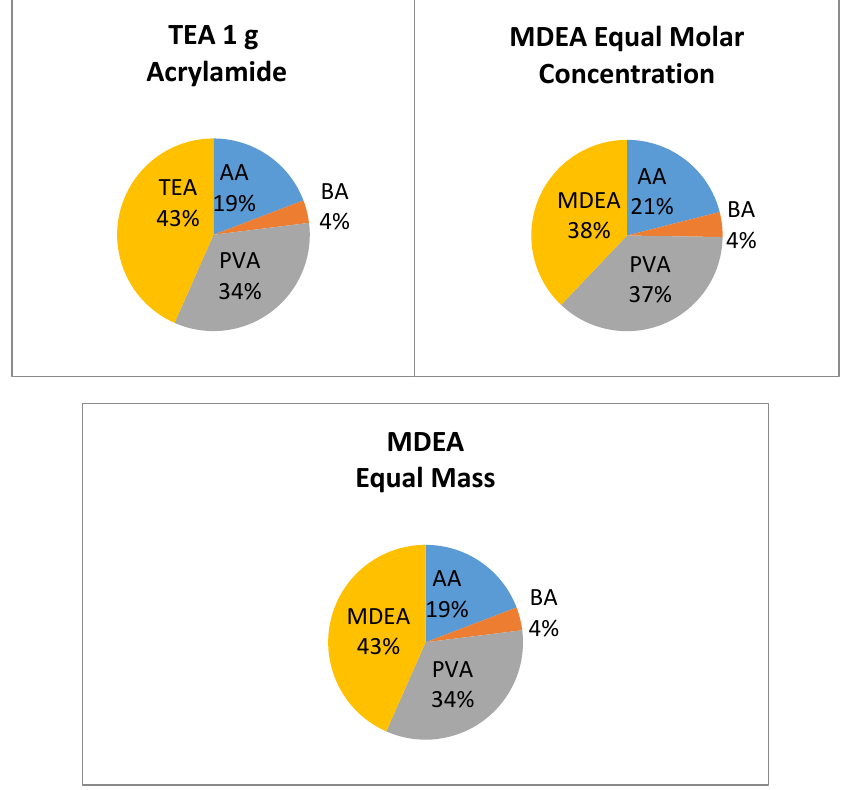
Figure 4. Mass distribution in the solid photopolymer layer. AA—acrylamide, BA-N,N’— Methylenebisacrylamide, TEA—Triethanolamine, MDEA—Methyldiethanolamine, PVA— Polyvinylalcohol.